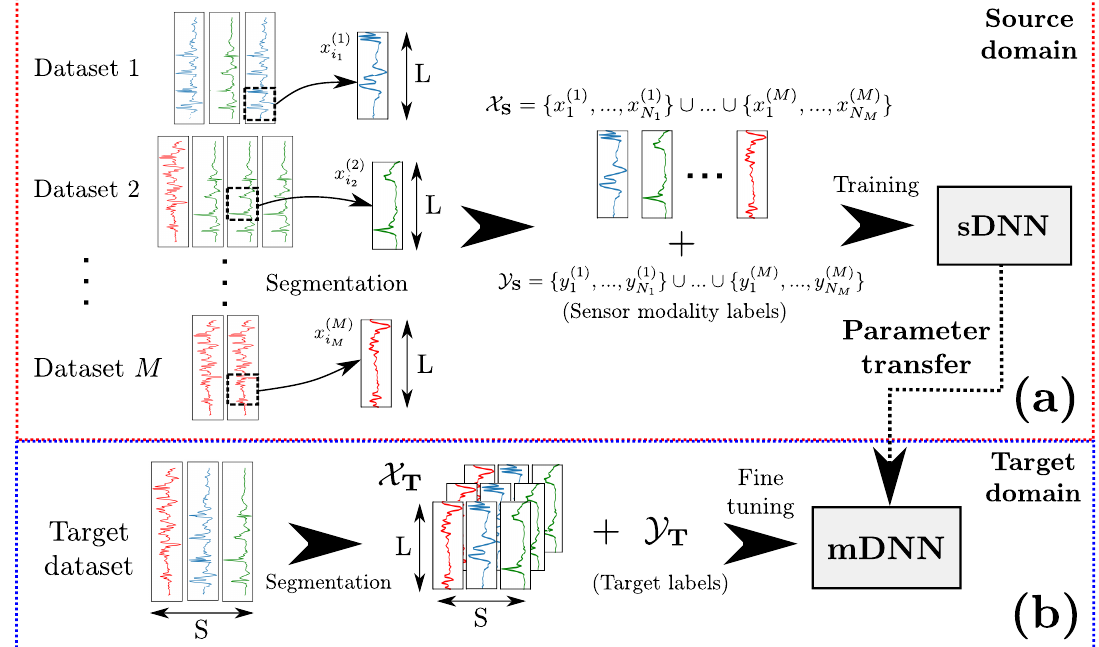
Figure 1. An overview of our transfer learning method. ( a ) A labelled source dataset of single-channel ( j ) sequences ( X S , Y S ) is created by collecting segments x of length L from M datasets and attributing i ( j ) them sensor modality labels y . ( X S , Y S ) is then used to train a sDNN that predicts the sensor i modality of each segment. ( b ) A mDNN is built to learn the predictive target function f T . The weights of the trained sDNN are transferred to the mDNN. The latter is then fine-tuned on the target domain using ( X T , Y T )